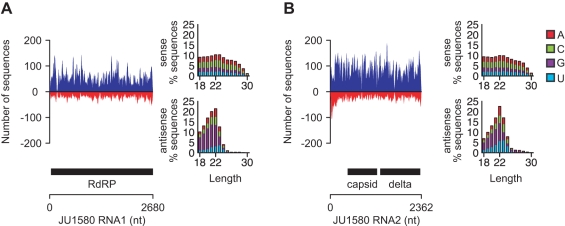
Small RNAs produced upon viral infection.Number of unique sequences obtained by Illumina/Solexa high-throughput sequencing of a 5′-independent small RNA library from JU1580 matching a given position in the Orsay virus segment RNA1 (A) or RNA2 (B). The number of sequences in sense and antisense orientation are shown on the positive (blue) and negative (red) y-axis, respectively. Only sequences with a perfect and unambiguous match to the virus genome were considered. The location of virus protein-coding genes is indicated below each graph as black bars and the RNA genome as a line. Features of sense and antisense sequences (length and identity of first nucleotide) are shown to the right of each graph.